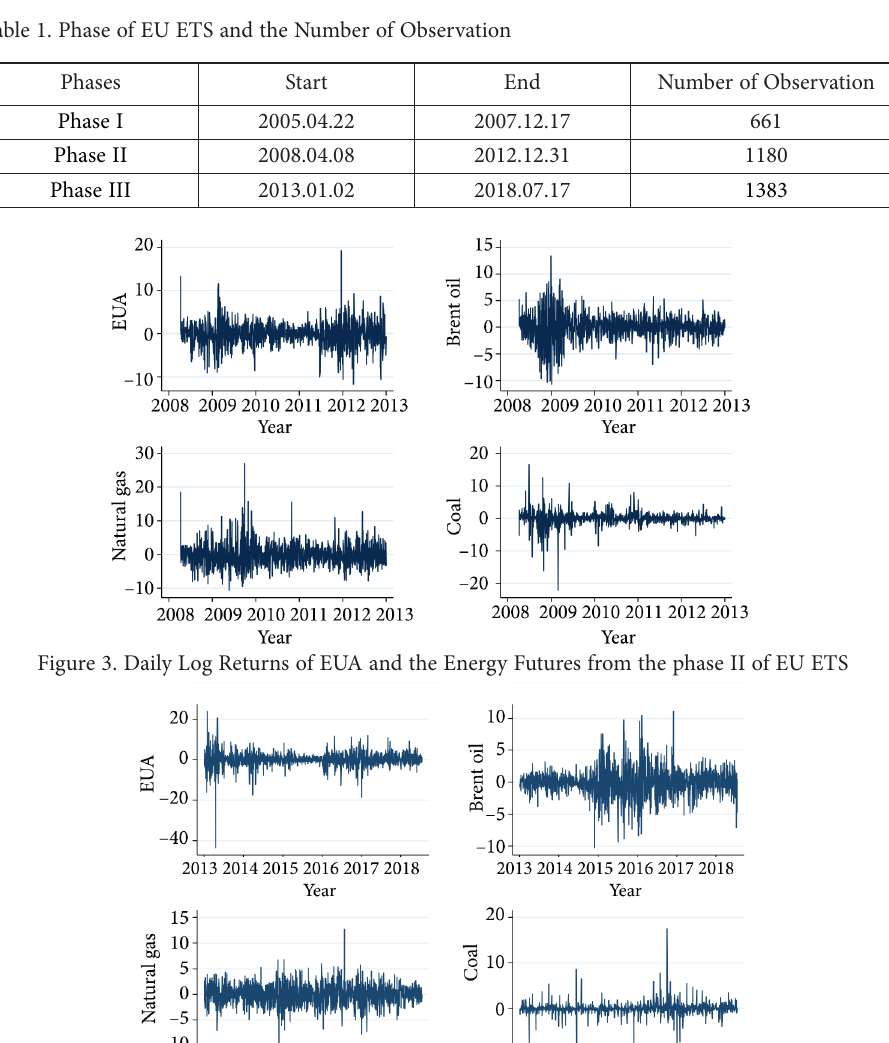
Figure 4. Daily Log Returns of EUA and the Energy Futures from the phase III of EU ETS